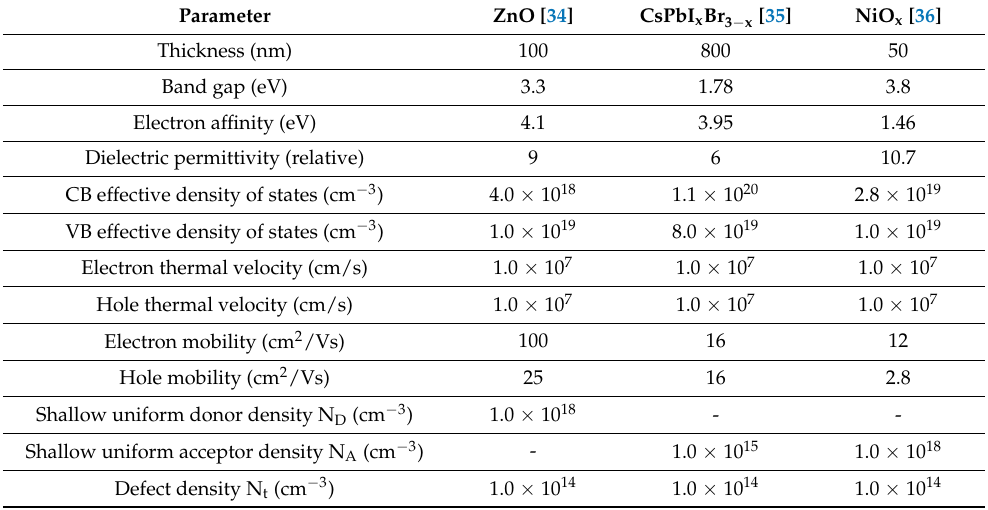
Table 1. PhysicalparametersofZnO,CsPbI x Br 3 − x ,andNiO x usedintheITO/ZnO/CsPbI x Br 3 − x /NiO x /Au